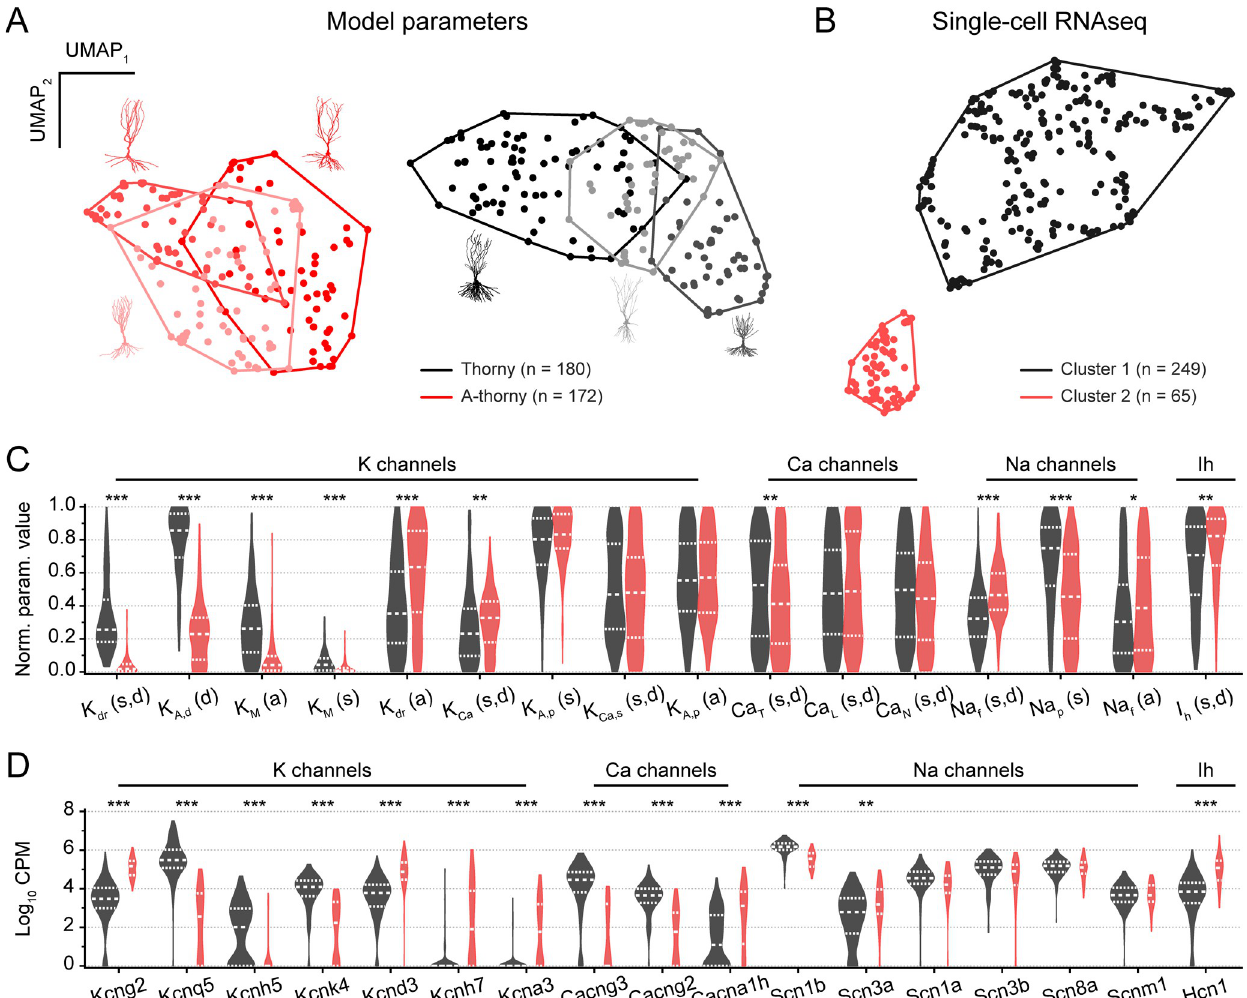
Fig 3. Distributions of model parameters mirror differentially expressed ion channel genes. (A) Bidimensional representation of parameter values transformed using UMAP: each dot represents one individual, and closed lines indicate the convex hulls associated with all the individuals obtained with a given morphology (color-coded accordingly to both the convex hull and the points contained in it). (B) UMAP projection and clustering of CA3 excitatory neurons based on scRNAseq data. Using the Leiden clustering algorithm with a resolution of 0.65 delineated the primary division in the CA3 principal neuron population. Note that CA3 principal cells are primarily composed of a larger population of cells (cluster 1, black) and a second minority population (cluster 2, red). (C) Violin plots of the distributions of maximal conductance values for four different classes of ion channels (potassium, calcium, sodium and hyperpolarization-activated) for the model cells included in the analysis, normalized over the range of allowed variability of each parameter as reported in S2 Table (black and red indicate thorny and a-thorny cells, respectively). Dashed lines indicate the median of the population, while the upper and lower dotted lines represent the 25th and 75th percentile of the distributions. Most parameter distributions were significantly different between the two cell-types (non-parametric Kolmogorov-Smirnov test: � p < 0.05, �� p < 0.01, ��� p < 0.001). For the remaining parameters see S1 Fig. (D) Expression levels for cells belonging to cluster 1 (black) or cluster 2 (red) for analogous classes of ion channel genes as shown in (C). Note that expression levels for most Na channel genes were not significantly different while Ca and K channel genes were significantly differentially expressed between the two clusters (non-parametric Kolmogorov-Smirnov test: � p < 0.05, �� p < 0.01, ��� p < 0.001).